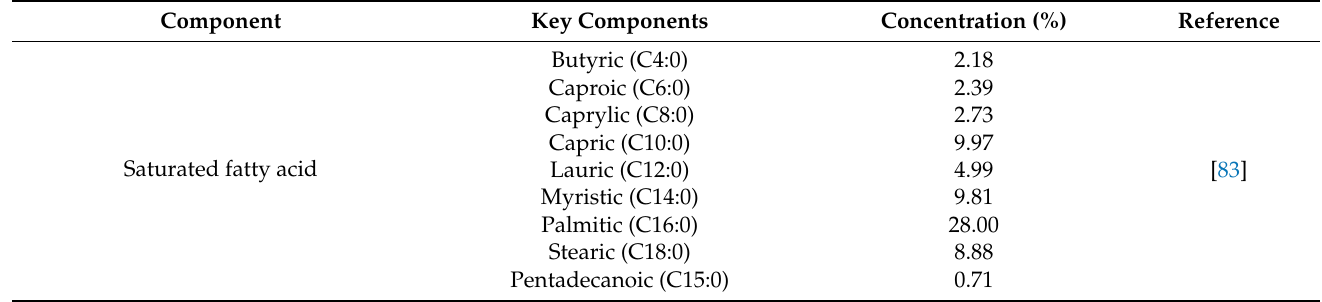
Table 3. Different components of fats and their compositions are present in GM. Component Key